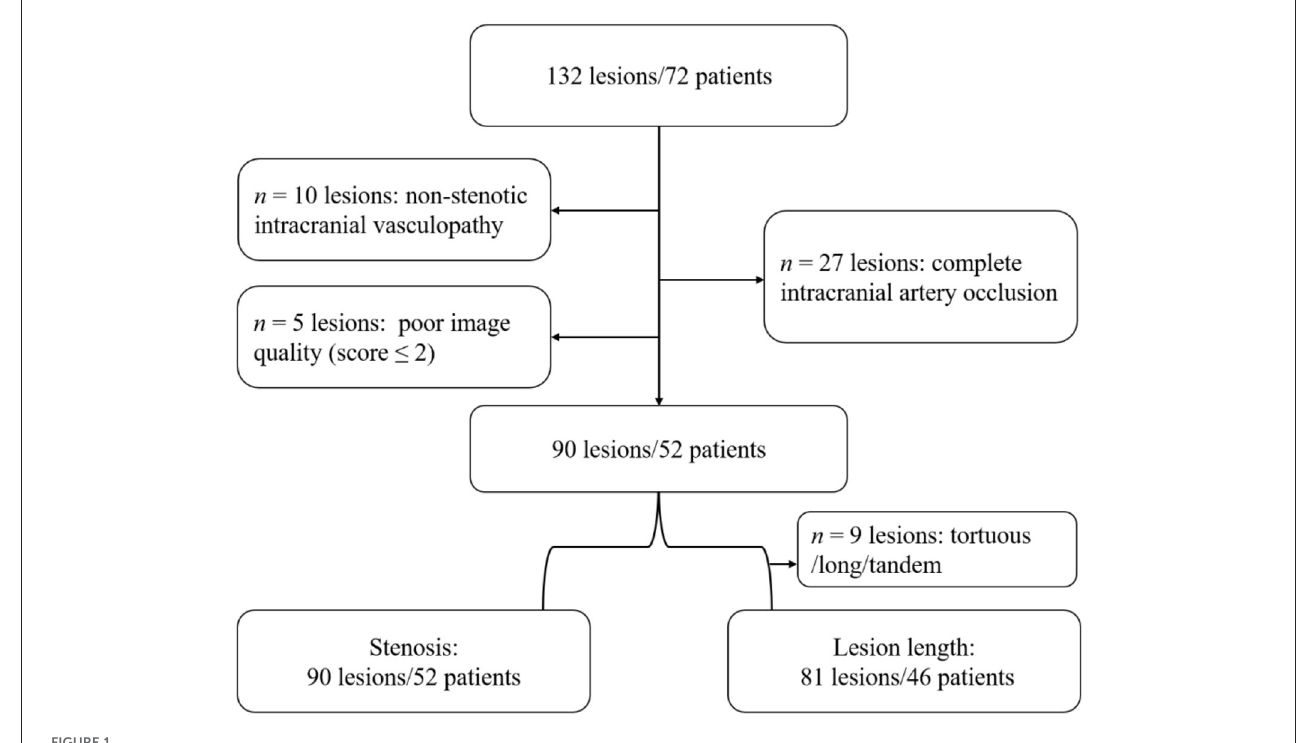
FIGURE1 Flowchart of study population selection.